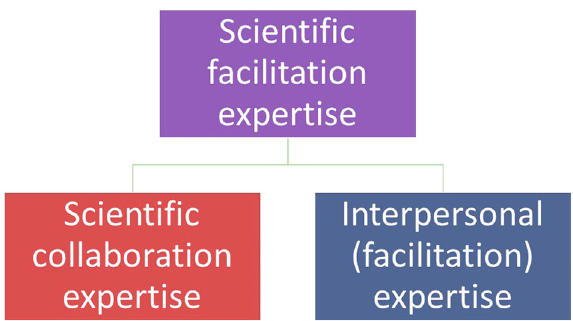
Fig. 1 The composition of science facilitation expertise. Science facilitation expertise is a combination of expertise in scienti fi c collaboration and interpersonal expertise as applied to facilitation